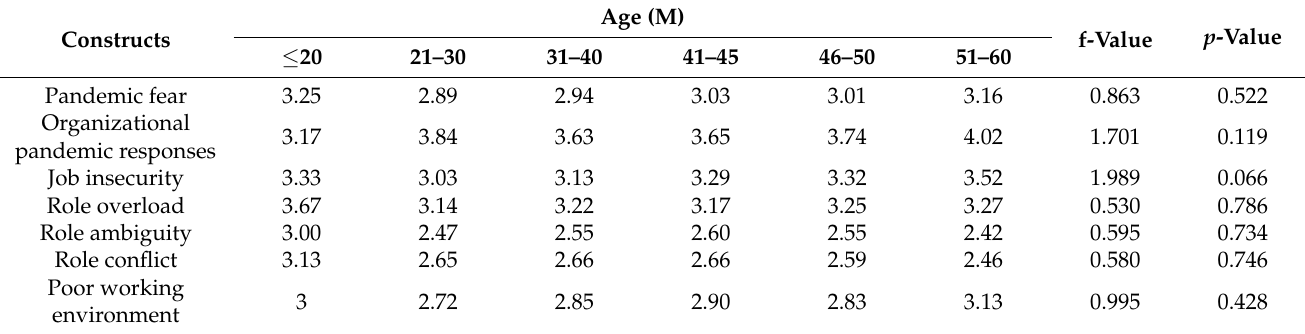
Table 10. ANOVA analysis of